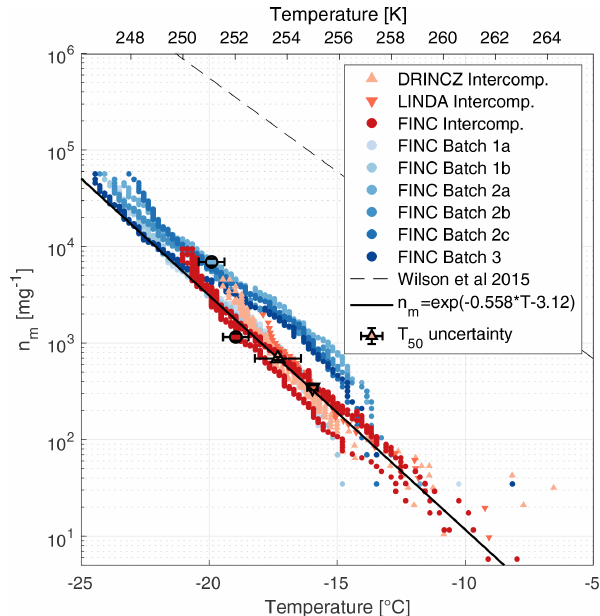
Figure 6. Ice-active mass site density ( n m ) of lignin measured by FINC, DRINCZ, and LINDA. Lignin was measured during the in- tercomparison on FINC (30µL well volume; three replicates; dark red dots), DRINCZ (50µL well volume; four replicates; orange tri- angles), and LINDA (100µL well volume; one replicate; red tri- angles). Additionally, different product batches of lignin were mea- sured by FINC (5µL well volume; six experiments, blue dots). Note that the markers of batches 1a and 1b are partially hidden behind the orange intercomparison markers. All lignin solutions were of concentration 20mgCL − 1 . The black line is the empirical fit of the intercomparison data only ( n m = exp ( − 0 . 558 × T − 3 . 12 ) ). The parameterization of the sea surface microlayer organic matter from Wilson et al. (2015) is also shown (dashed lined). Error bars in the x and y direction are shown on the T 50 value for one sample each from DRINCZ, LINDA, and FINC batch experiments, as well as FINC intercomparison experiments (see Supplement Sect. S11 for details). Note that the y -direction uncertainties do not extend be- yond the